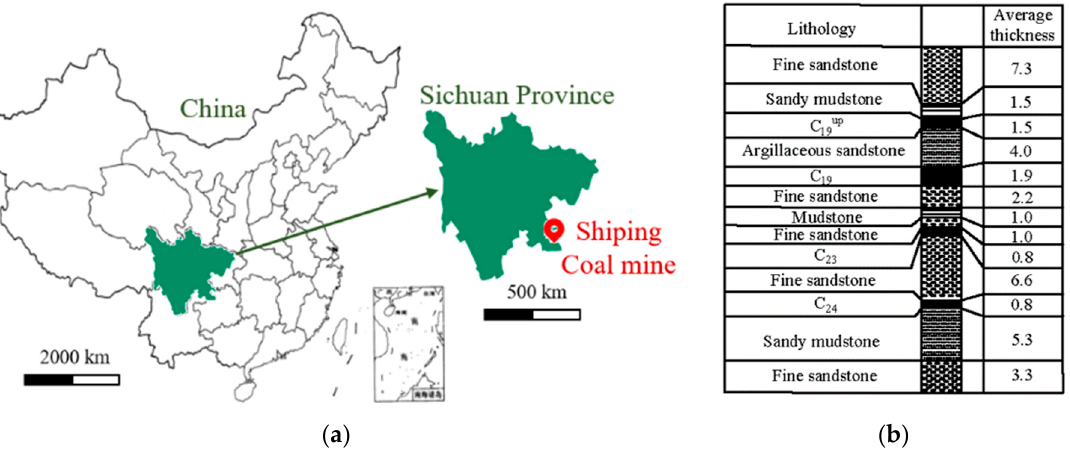
Figure 1. Position of coal mine and lithology histogram. ( a ) Position of coal mine. ( b ) Lithology histogram.